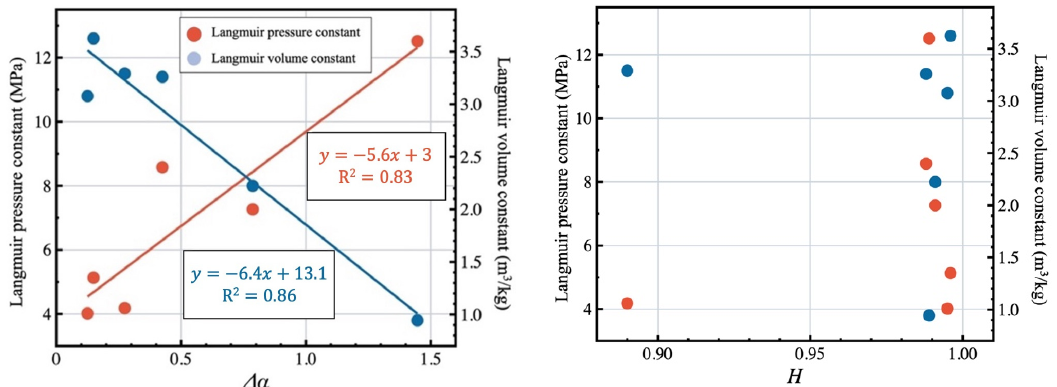
Figure 9. Schematic of the gas adsorption test system (the fi gure has been adapted from a Shandong University of Science and Technology introduction to test systems in gas di ff usion dynamics).